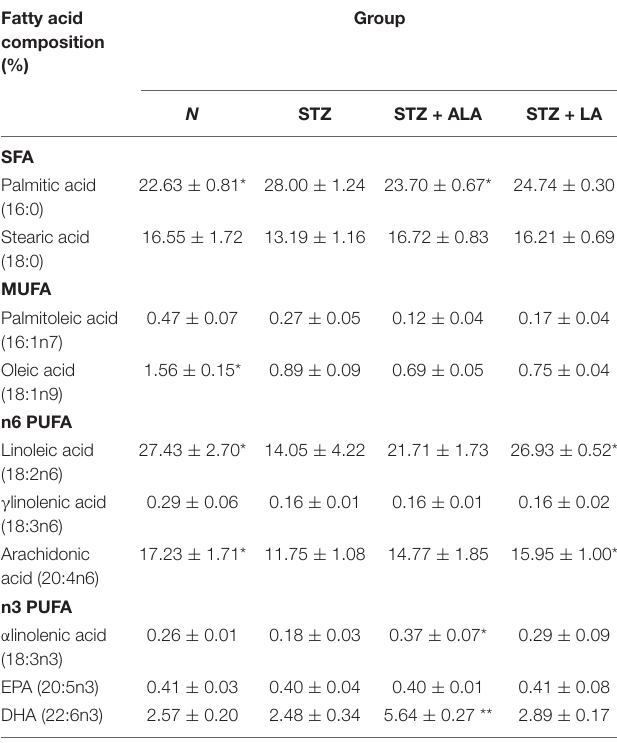
TABLE 2 | Plasma fatty acid composition of the experimental animals. Fatty acid